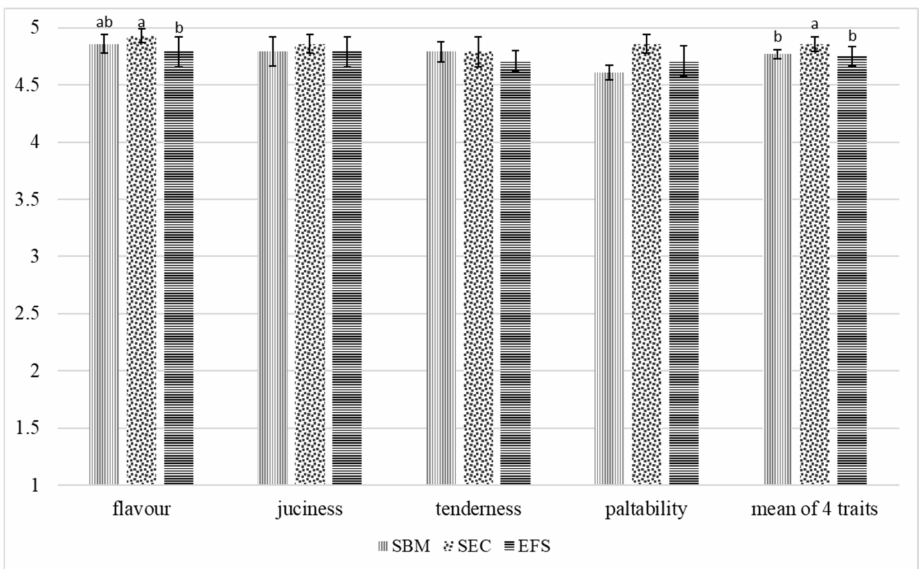
Figure 2. Sensory evaluation of thigh muscles (point). a,b—means with different superscripts within a row are significantly different at p <